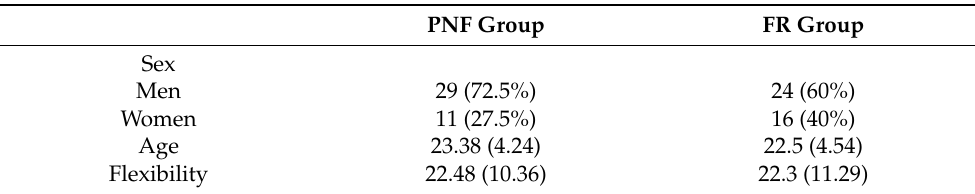
Table 1. Shows the descriptive characteristics of the initial sample and group homogeneity. Initial descriptive